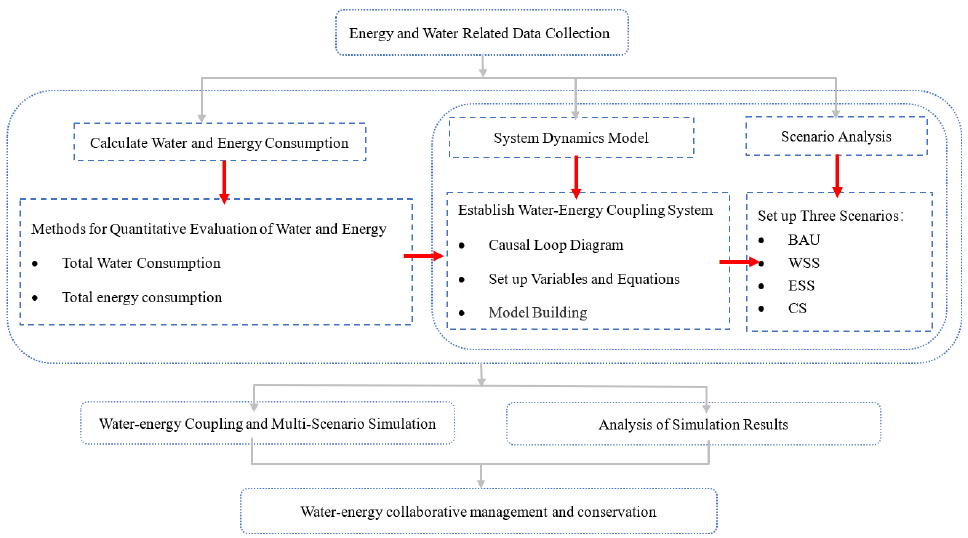
Figure 2. Research flowchart based on the system dynamics model for Ningbo.